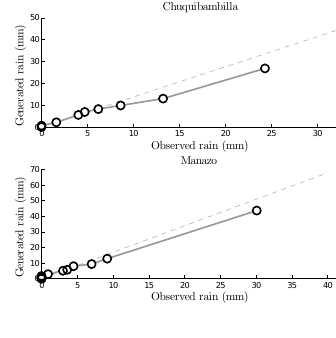
Figure 20. Quantile–quantile plots dry